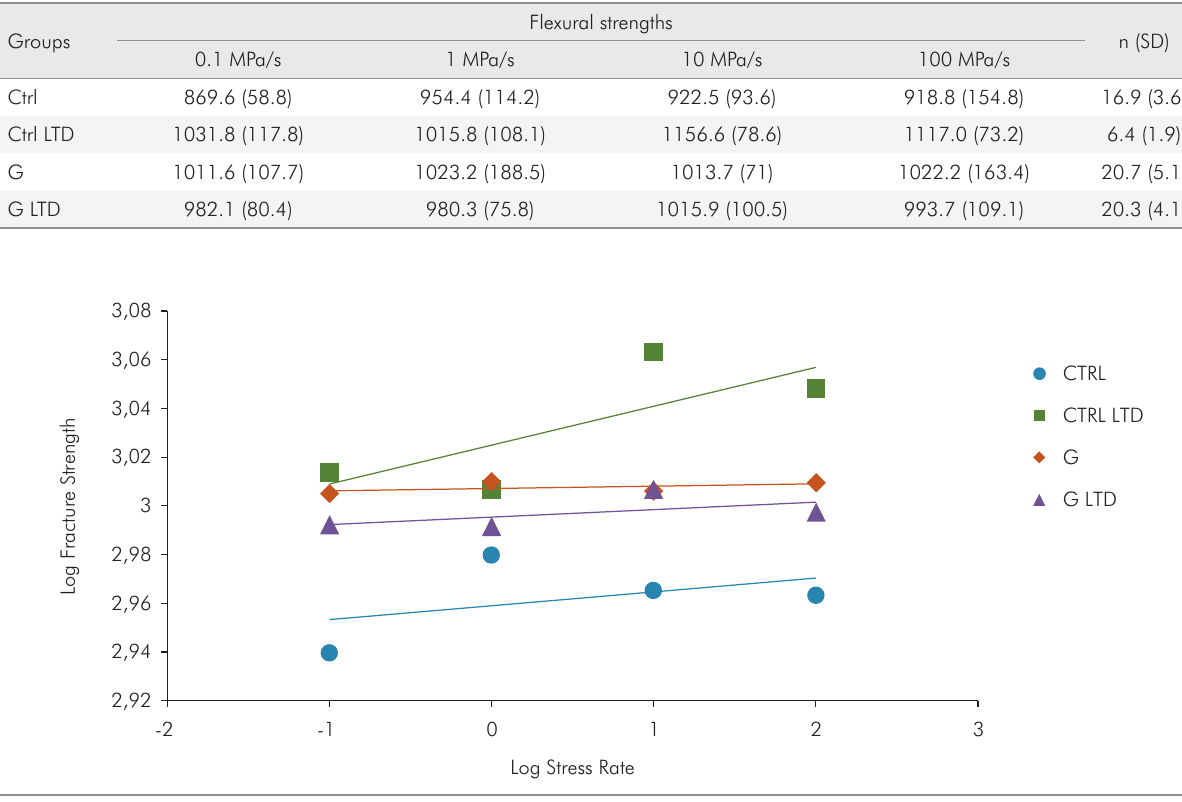
Figure 2. Curves of every group tested, with different slopes, indicating different susceptibility to slow crack growth.